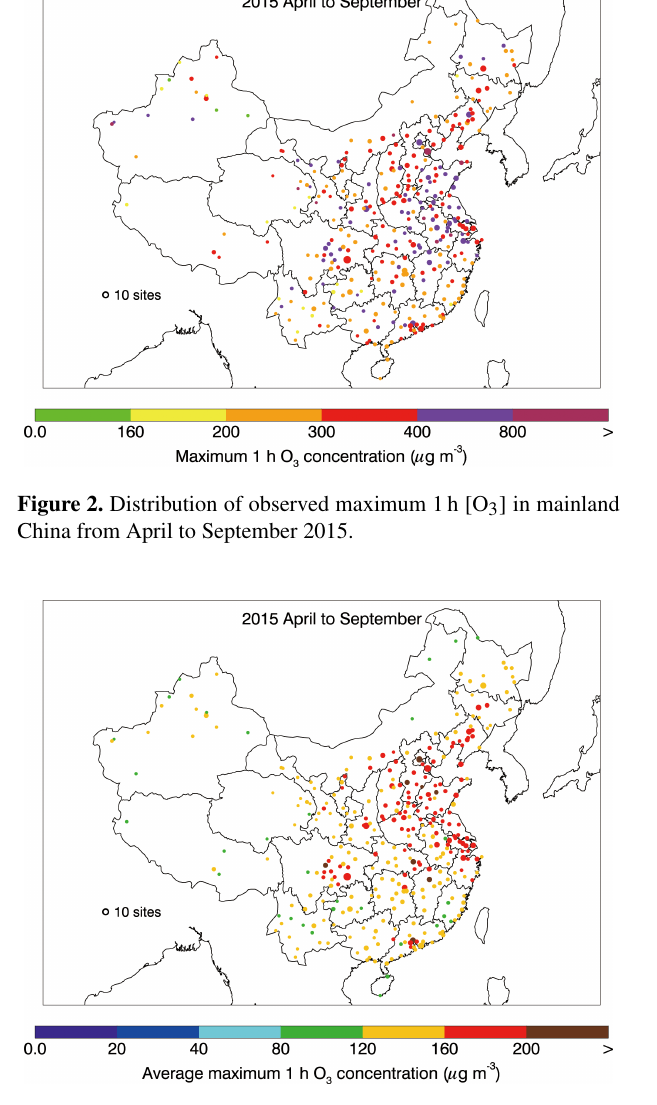
Figure 5. Distribution of days with the maximum 1h [O 3 ] exceed- ing 200µgm − 3 in mainland China from April to September